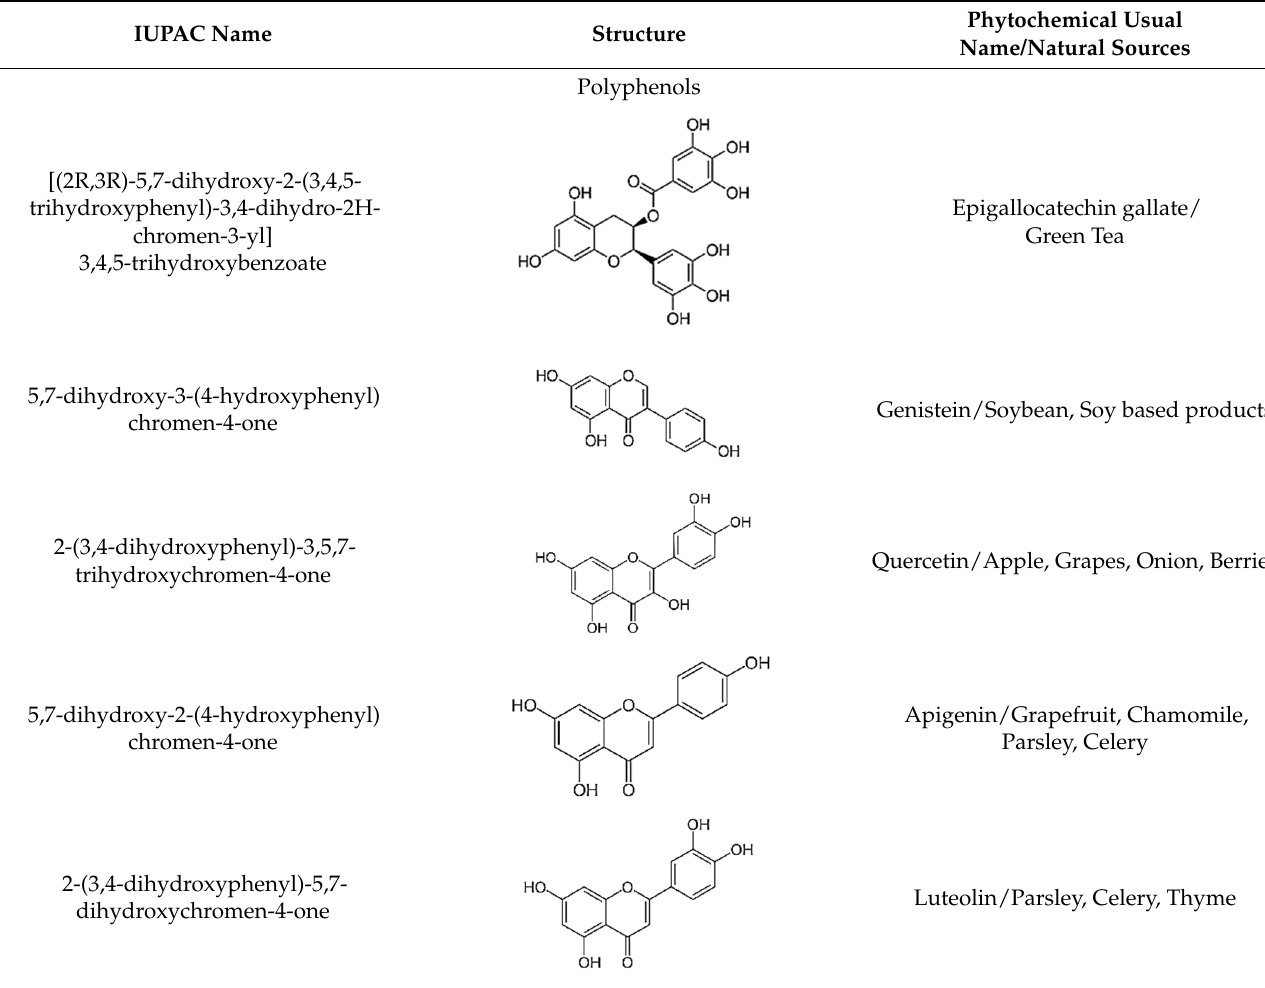
Table 1. Phytochemicals showing effects against breast cancer cell lines.